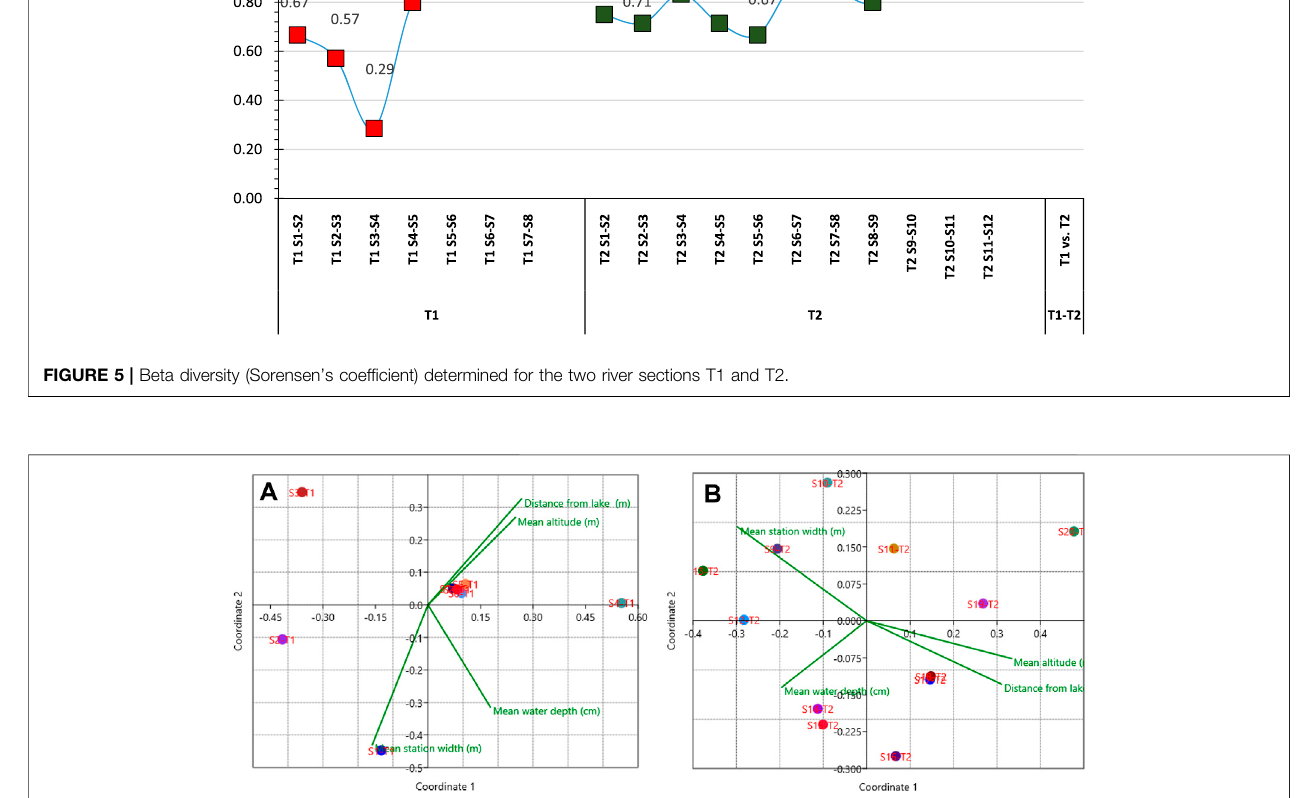
Frontiers in Environmental Science |